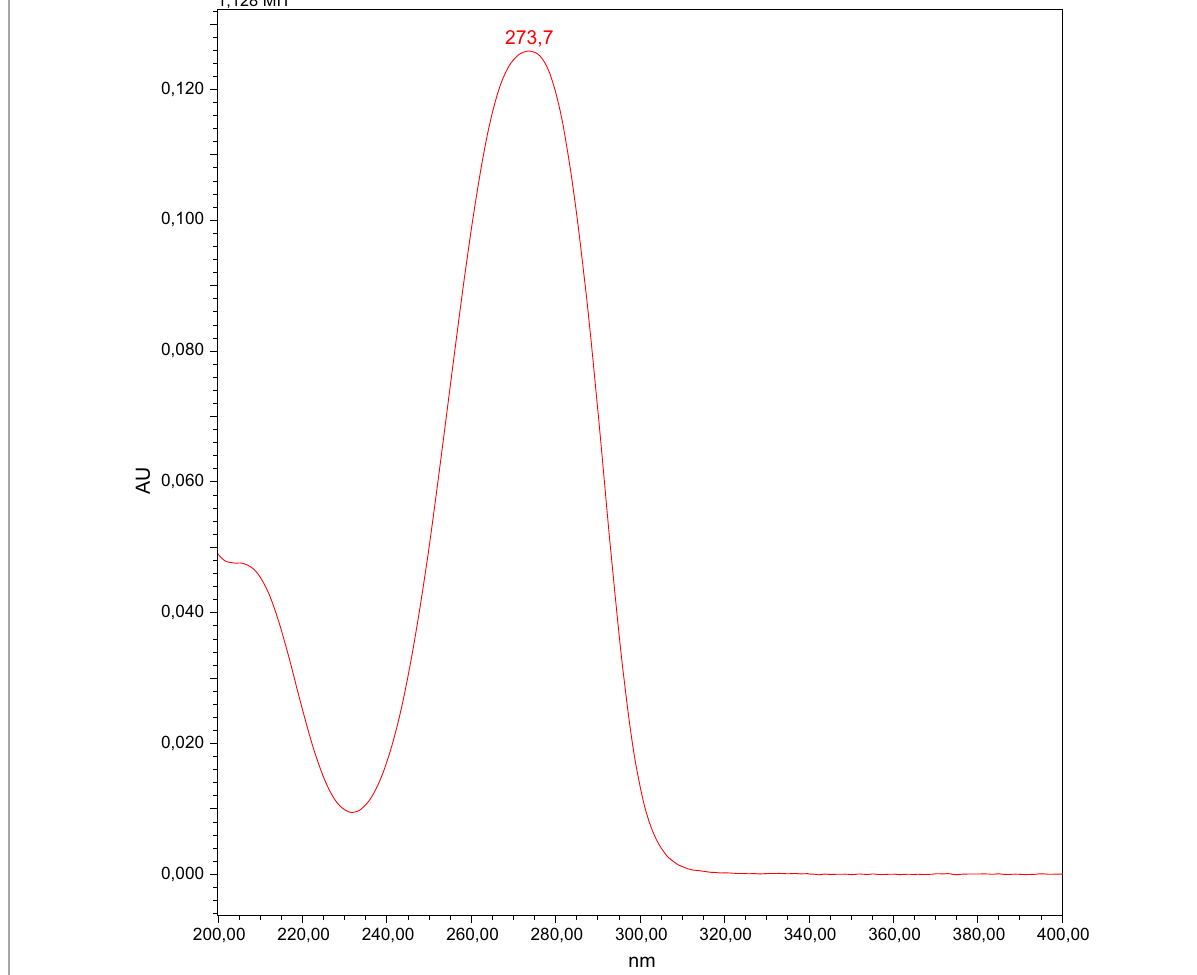
Fig. 1 UV‑spectrum of MI. Chromatographically analysis of MI, the maximum peak is seen at 273.3